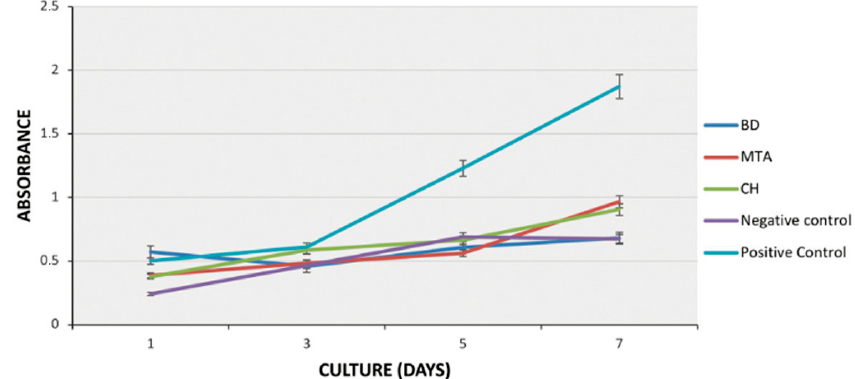
Figure 1 - Effect of medium conditioned by calcium hydroxide (CH), mineral trioxide aggregate (MTA) or Biodentine TM (BD) on the viability of stem cells from exfoliated deciduous teeth (SHED). Cells were incubated with conditioned media (1 mg/mL) for 7 days, at 37°C, and then subjected to the MTT assay. Regular growth medium (alpha-MEM with 10% FBS) or medium with 20% FBS were used as negative and positive control, respectively. Data represent mean ± SD (n=3 independent experiments, performed in